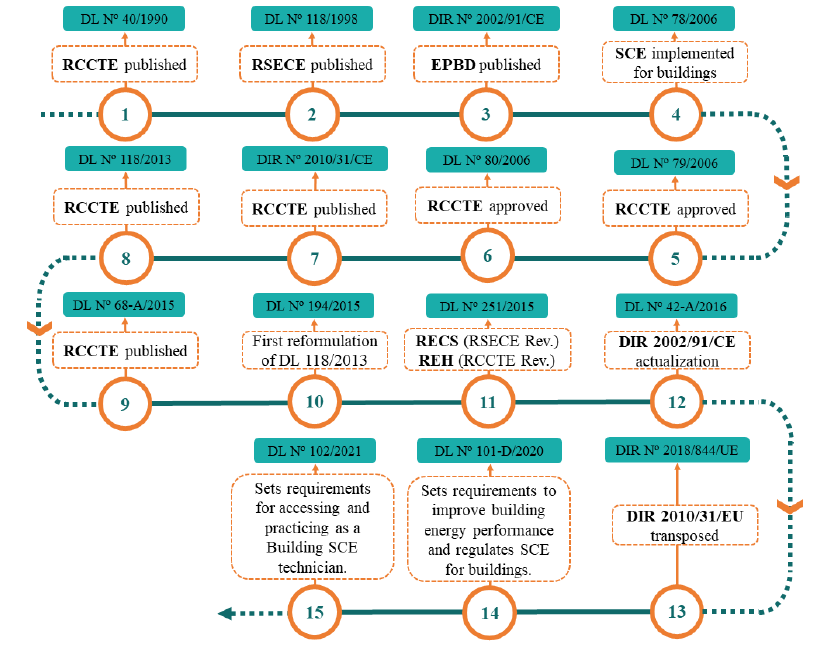
Figure 2. Timeline of Portugal’s energy efficiency policies in buildings.